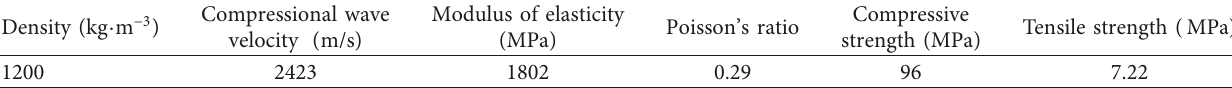
Table 4: Physical and mechanical parameters of transparent hard rock-like material.